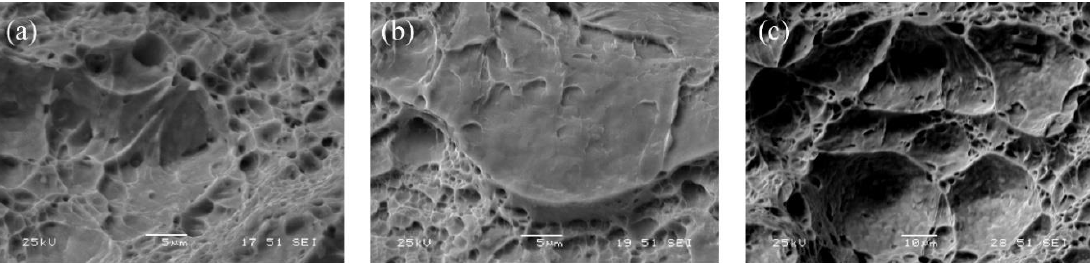
Figure 1. Fracture surface after tensile test of following samples; ( a ) S(540,5), shows ductile fracture of HAZ ( b ) S(640,50), shows brittle fracture of HAZ and ( c ) reference